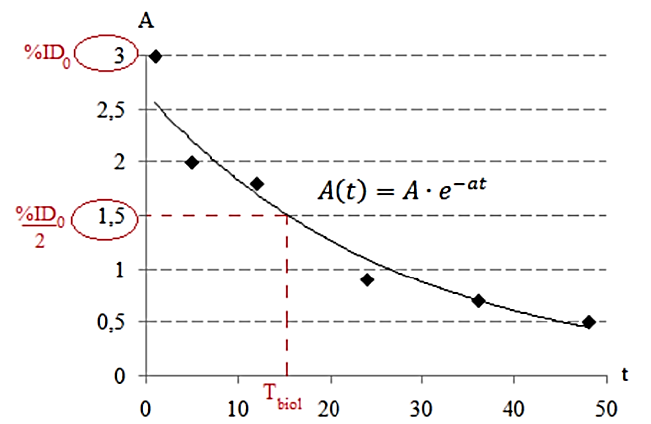
Figure 1. Mathematical model of the dynamics of changes in the concentration of radiopharmaceuticals over time in the organ.